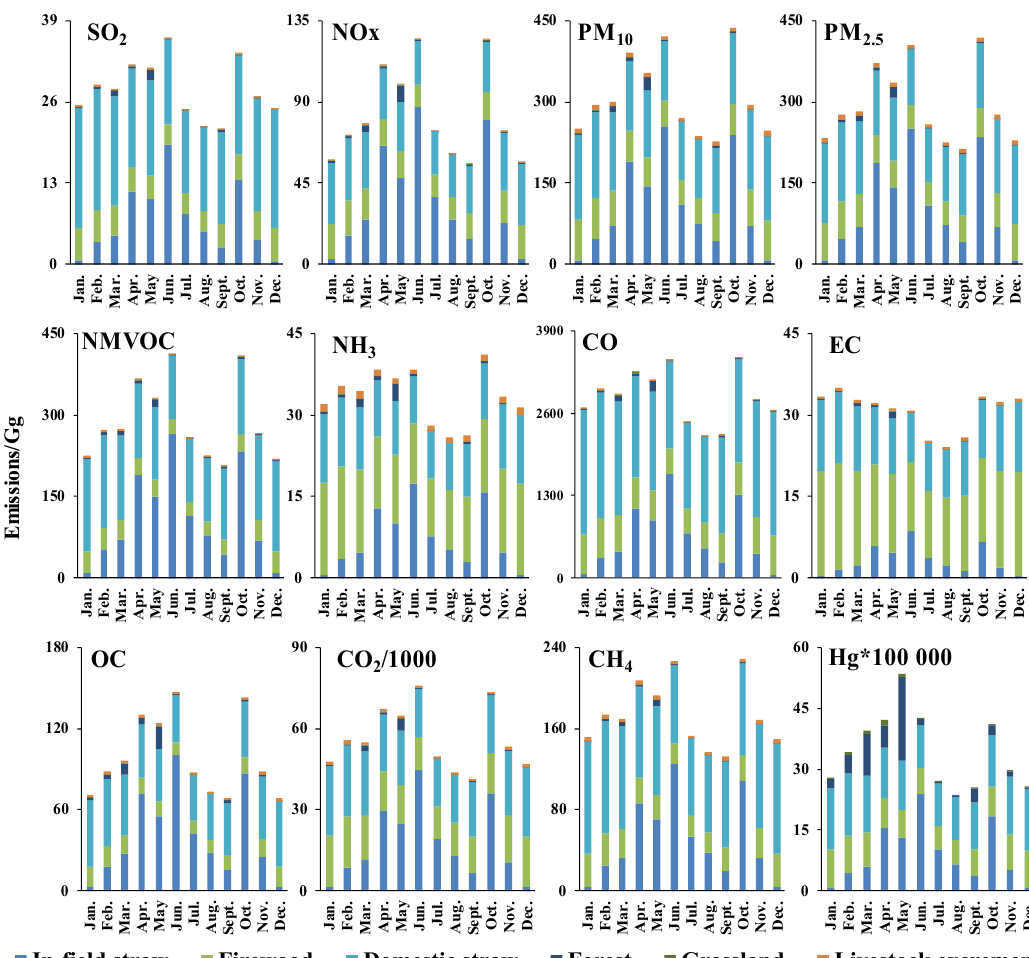
Figure 8. Monthly variation of different biomass sources emission for each